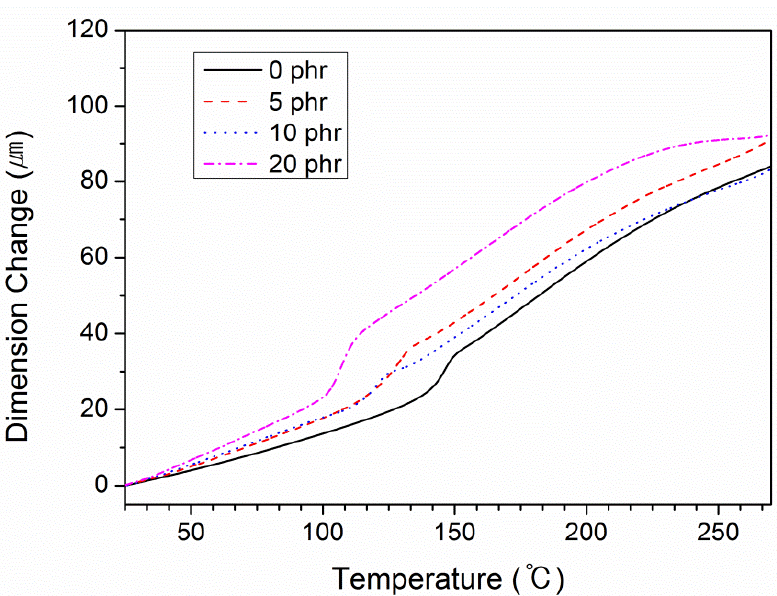
Figure 6. TMA graphs of epoxy compositions.